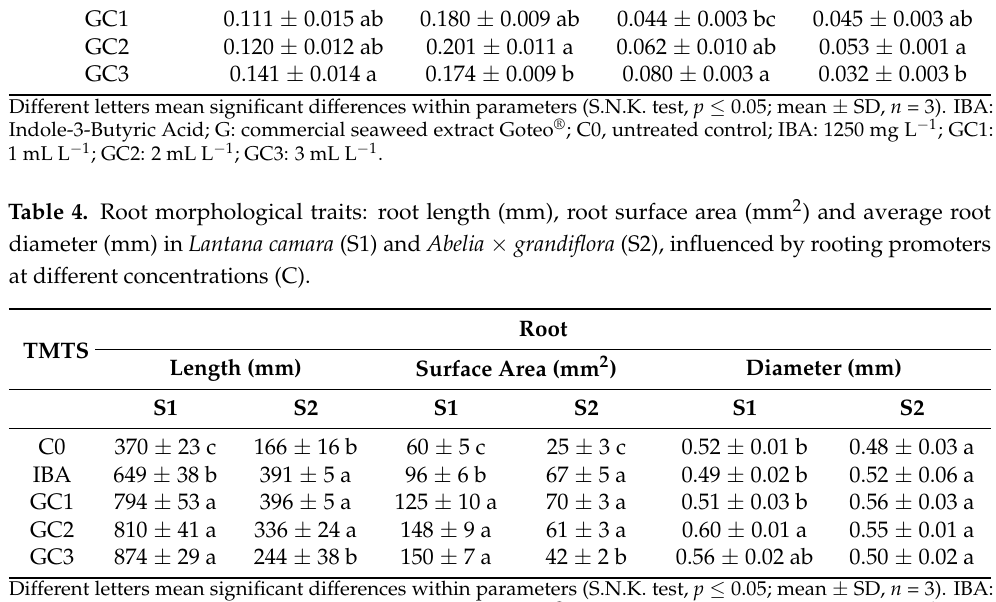
Table 3. Above-ground and ground dry weight (g) in Lantana camara (S1) and Abelia × grandiflora (S2), influenced by rooting promoters at different concentrations (C). Dry Weight per Cutting (g) TMTS Above-Ground Ground S1 S2 S1 S2 C0 0.091 ± 0.007 b 0.145 ± 0.012 b 0.031 ± 0.003 c 0.030 ± 0.001 b IBA 0.084 ± 0.009 b 0.143 ± 0.012 b 0.041 ± 0.003 bc 0.033 ± 0.003 b GC1 0.111 ± 0.015 ab 0.180 ± 0.009 ab 0.044 ± 0.003 bc 0.045 ± 0.003 ab GC2 0.120 ± 0.012 ab 0.201 ± 0.011 a 0.062 ± 0.010 ab 0.053 ± 0.001 a GC3 0.141 ± 0.014 a 0.174 ± 0.009 b 0.080 ± 0.003 a 0.032 ± 0.003 b